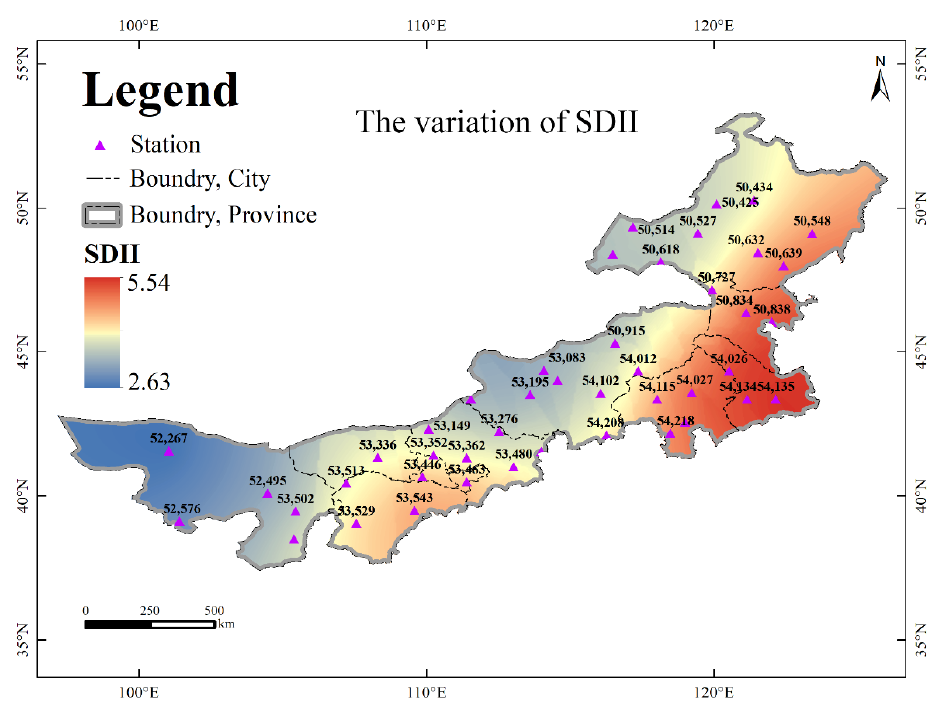
Figure 6. Spatial distribution of the mean SDII.